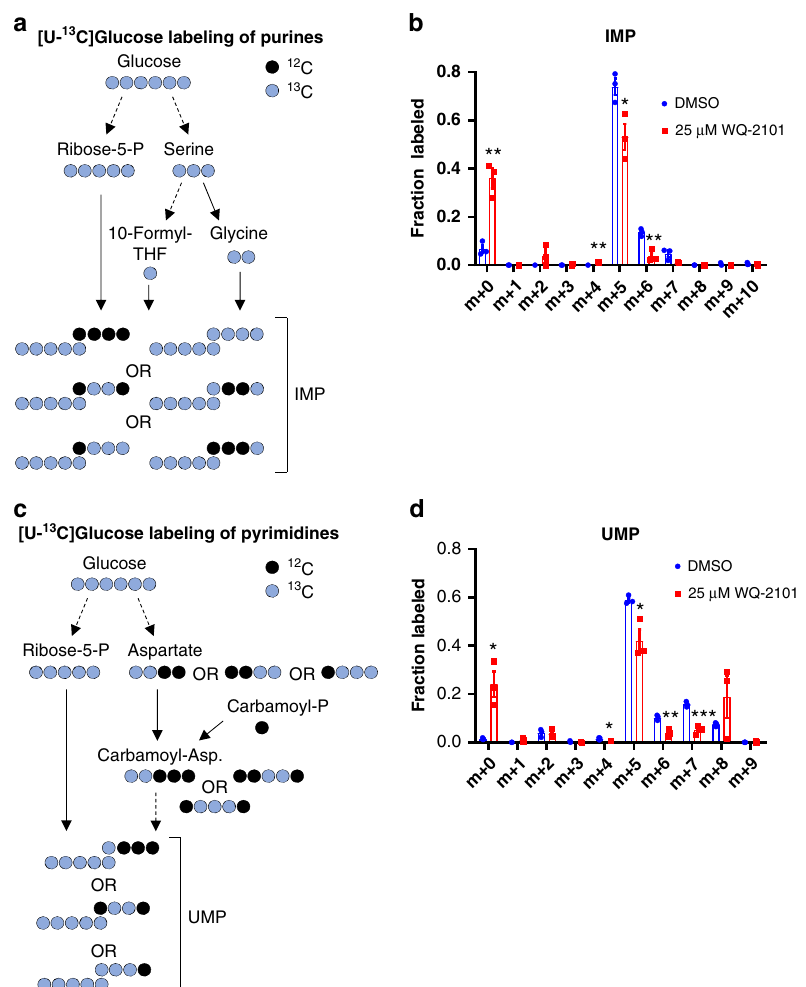
Fig. 3 Glucose incorporation into nucleotides is altered upon PHGDH inhibition. a Schematic of [U- 13 C] glucose labeling of purines. b Mass-isotopomer distribution (MID) of IMP (inosine monophosphate) from [U- 13 C] glucose in cells treated with 25 μ M WQ-2101. Data are the mean of three biological replicates, and error bars represent s.e.m. P < 0.05 [*], P < 0.01 [**], Student ’ s t -test. c Schematic of [U- 13 C] glucose labeling of pyrimidines. d Mass- isotopomer distribution (MID) of UMP (uridine monophosphate) from [U- 13 C] glucose in cells treated with 25 μ M WQ-2101. Data are the mean of three biological replicates, and error bars represent s.e.m. P < 0.05 [*], P < 0.01 [**], P < 0.005 [***], Student ’ s t -test. For labeling experiments, cells were pre- treated with inhibitors for 4 h followed by introduction of [U- 13 C] glucose-containing medium including inhibitors for 20